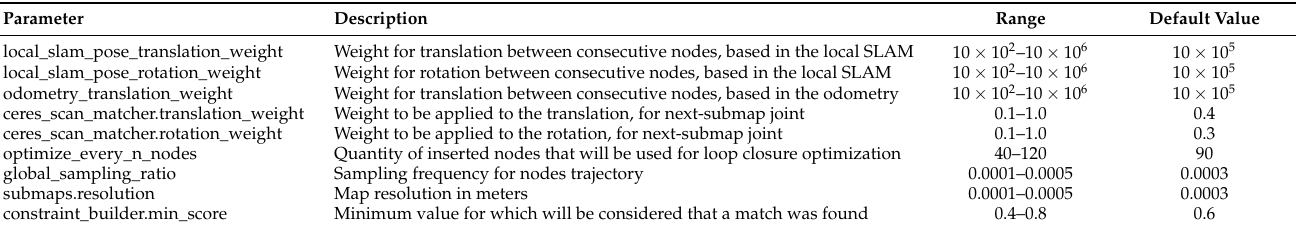
Table 1. List of Cartographer parameters.